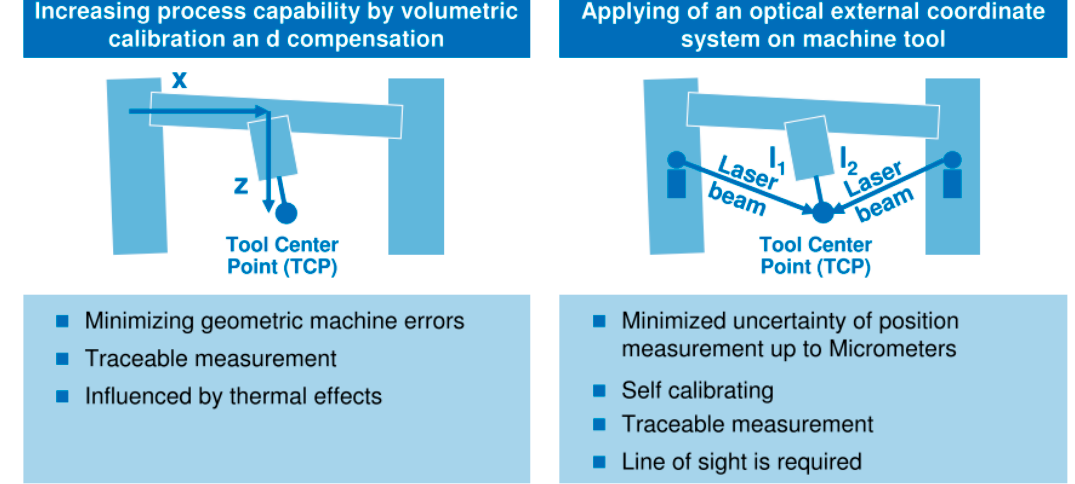
Figure 4. WZL RWTH Aachen approach to convert a MT into a CMM [7].